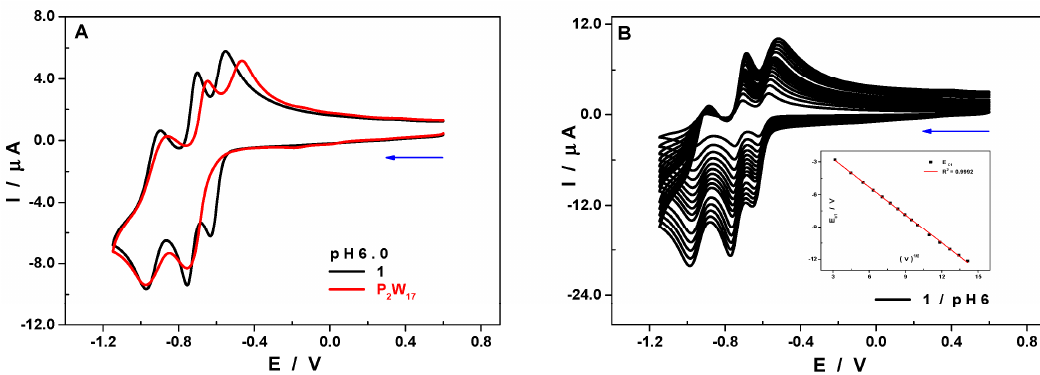
Figure 4. ( A ) Cyclic voltammetry (CV) of 1 (black) and P 2 W 17 (red) recorded at a scan rate of 50 mV.s − 1 . ( B ) CV of 1 , recorded at scan rates varying from 200 to 10 mV.s − 1 . The insert shows the variation of Ec 1 as a function of the square root of the scan rate. The CV are obtained in 1.0 M of LiOAc + HOAC/pH 6.0. POM concentrations: [1] = 0.20 mM, [P 2 W 17 ] = 0.4 mM. Working electrode: glassy carbon (GC); counter electrode: Pt gauze; reference electrode: